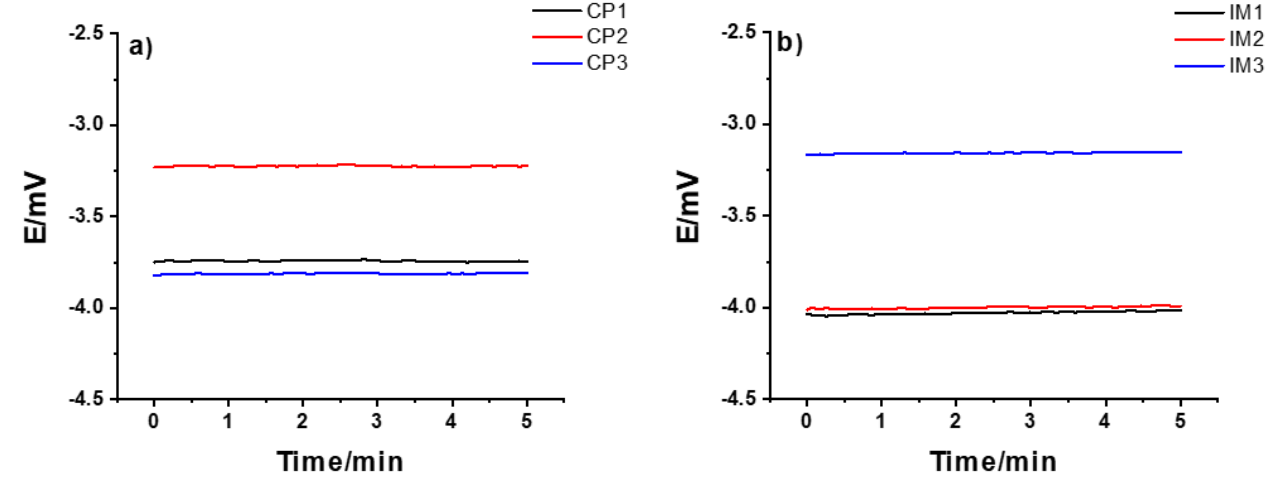
Figure 1. Potential stability of ( a ) CP SSC and ( b ) IM SSC electrodes measured in 10 − 1 MKCl .